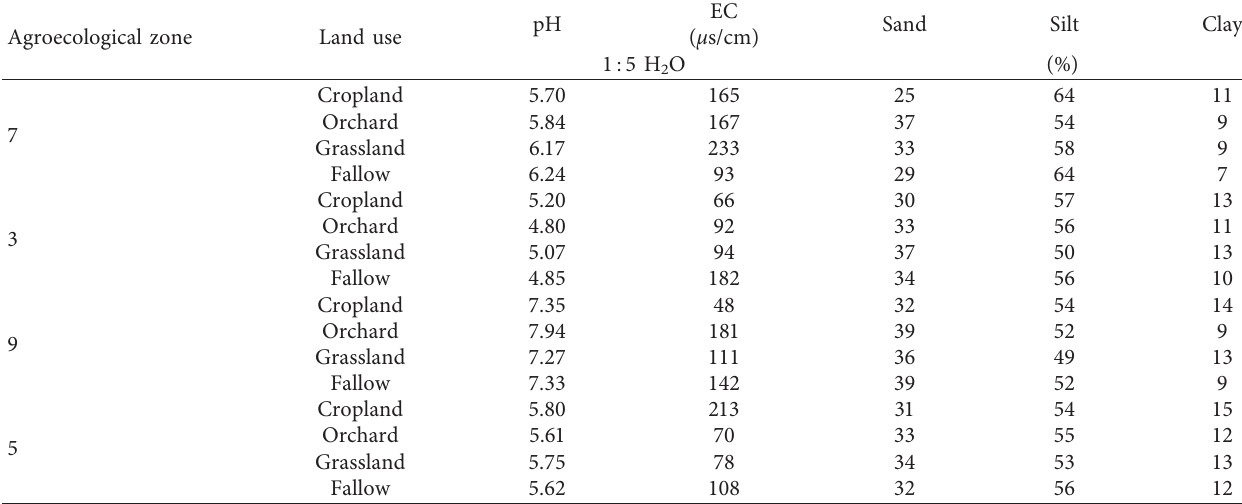
Table 2: General properties of bulk